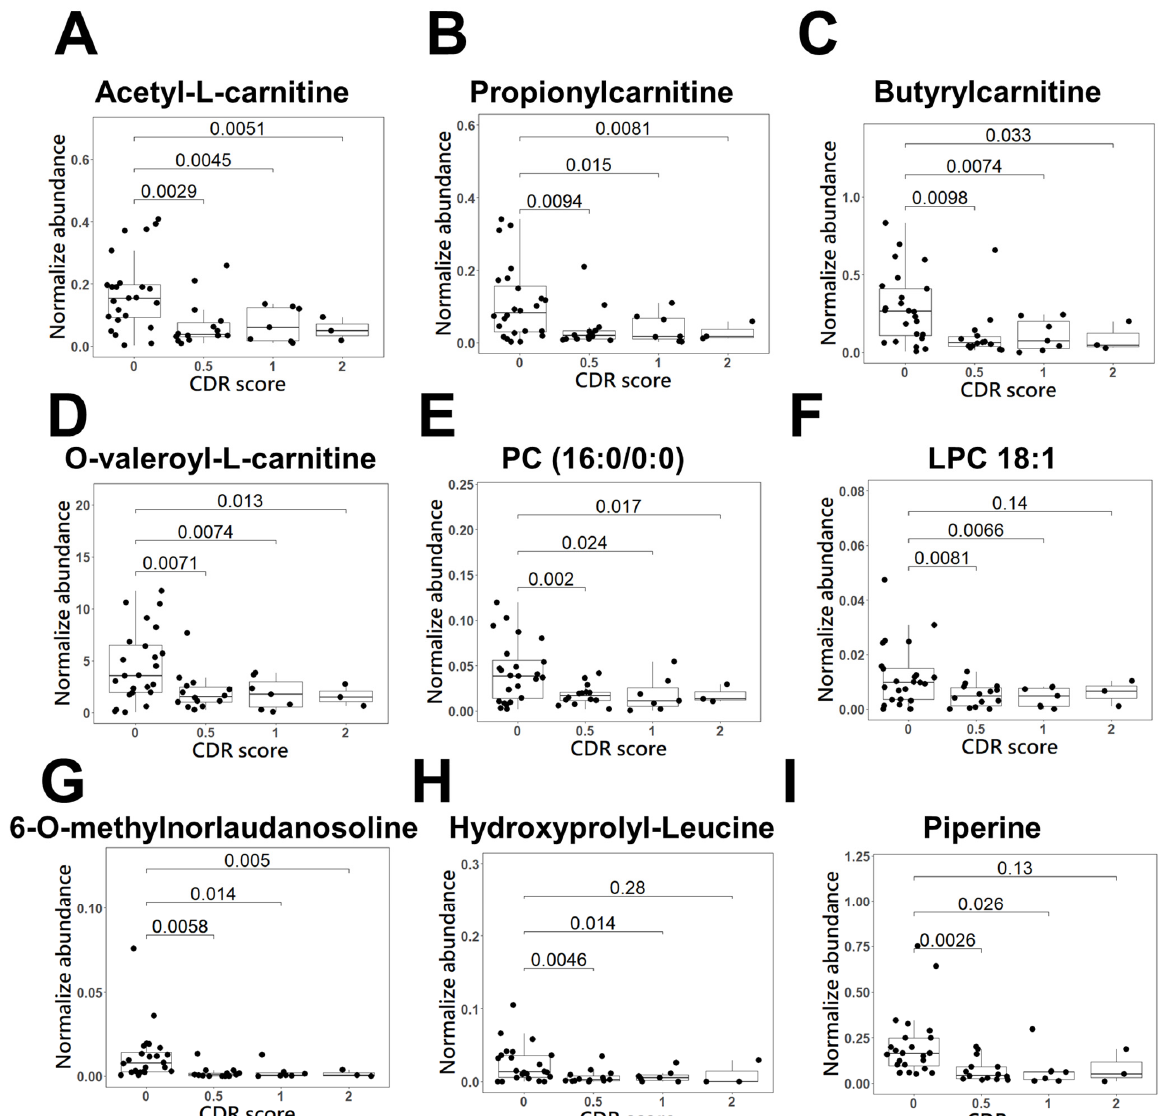
Figure 4. Scatter and box plots of candidate biomarker metabolites for early detection of AD dementia in the derived panel. The metabolites, ( A ) acetyl-L-carnitine, ( B ) propionylcarnitine, ( C ) butyrylcarnitine, ( D ) O-valeroyl-L-carnitine, ( E ) PC (16:0/0:0), ( F ) LPC 18:1, ( G ) 6-O-methylnorlaudanosoline, ( H ) hydroxyprolyl-leucine, and ( I ) piperine, represent the normalized metabolites intensity.